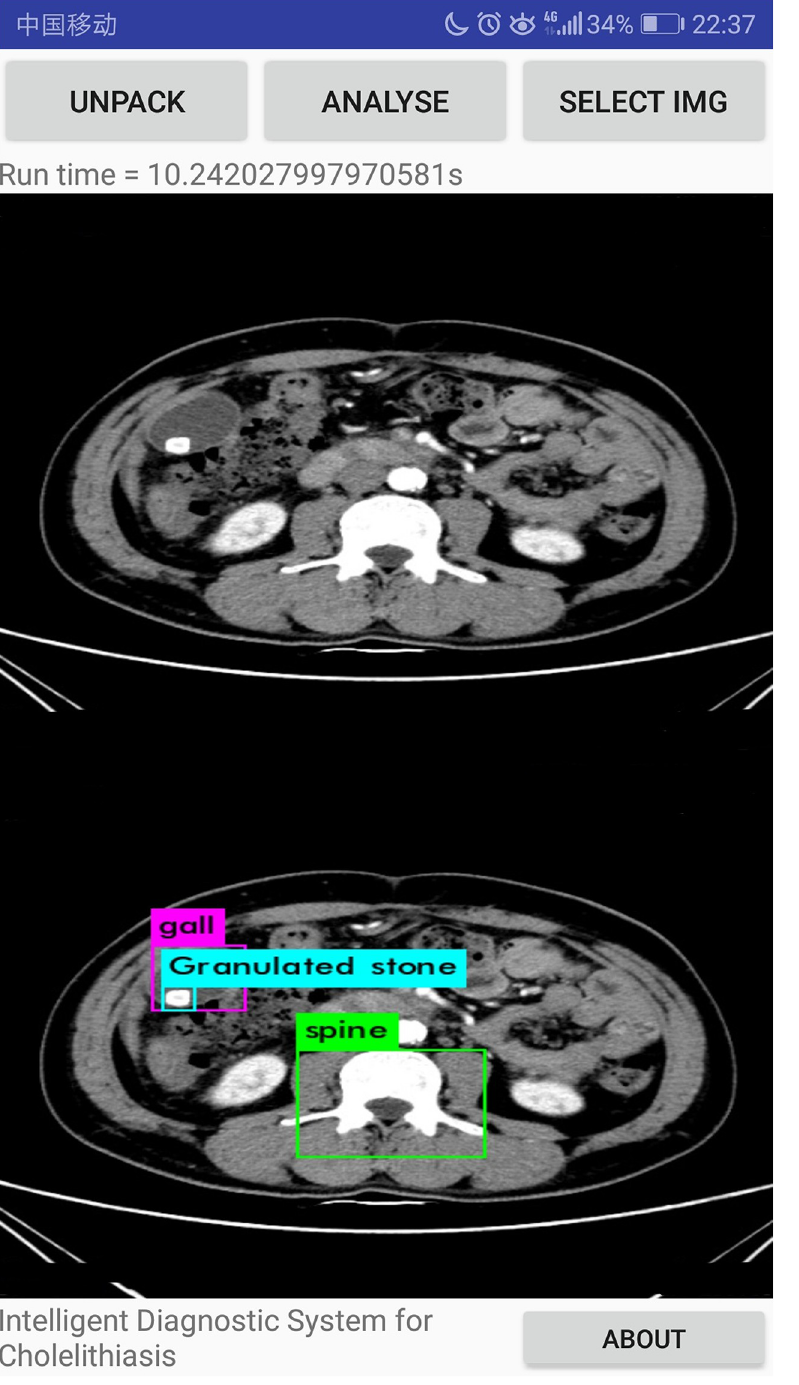
Fig 12. The experimental results that granulated stone is